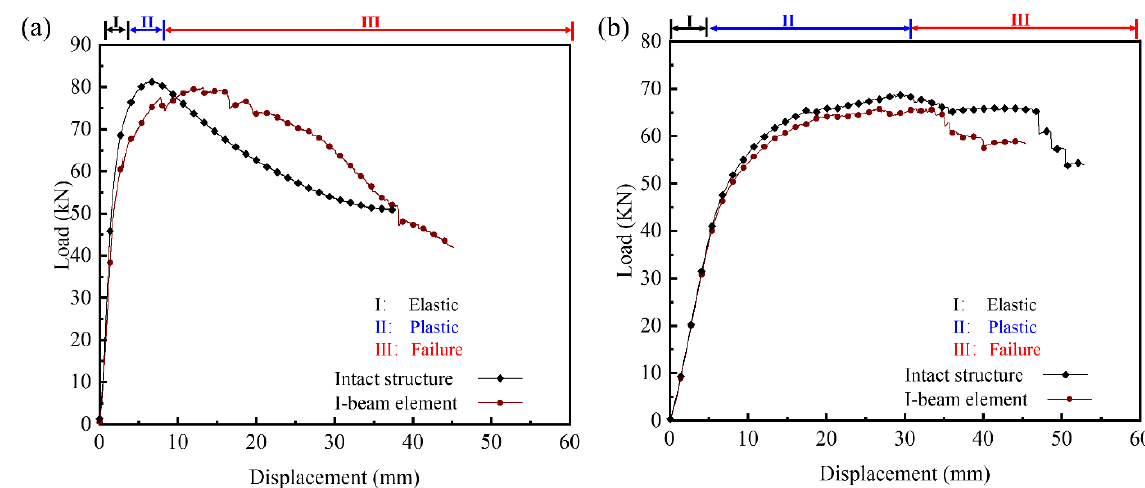
Figure 11. Experimental load-displacement curves for 2 types of panel-to-panel construction under three-point ( a ) and four-point ( b ) bending.